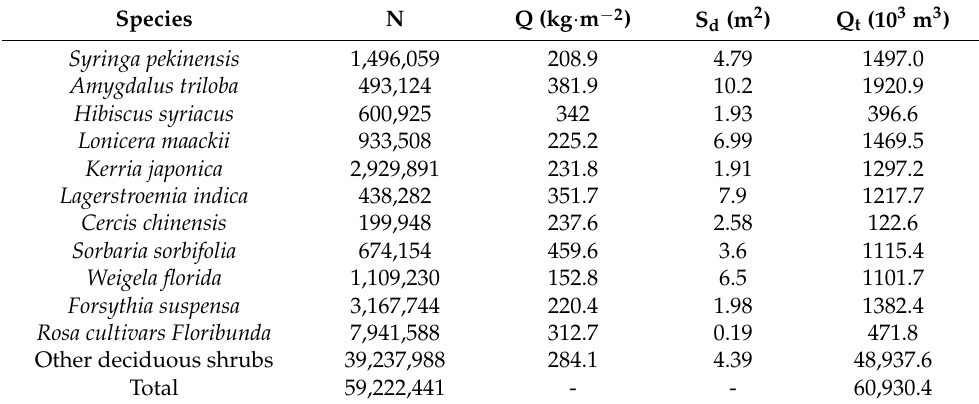
Table 10. Annual water consumption of deciduous shrubs in Beijing.